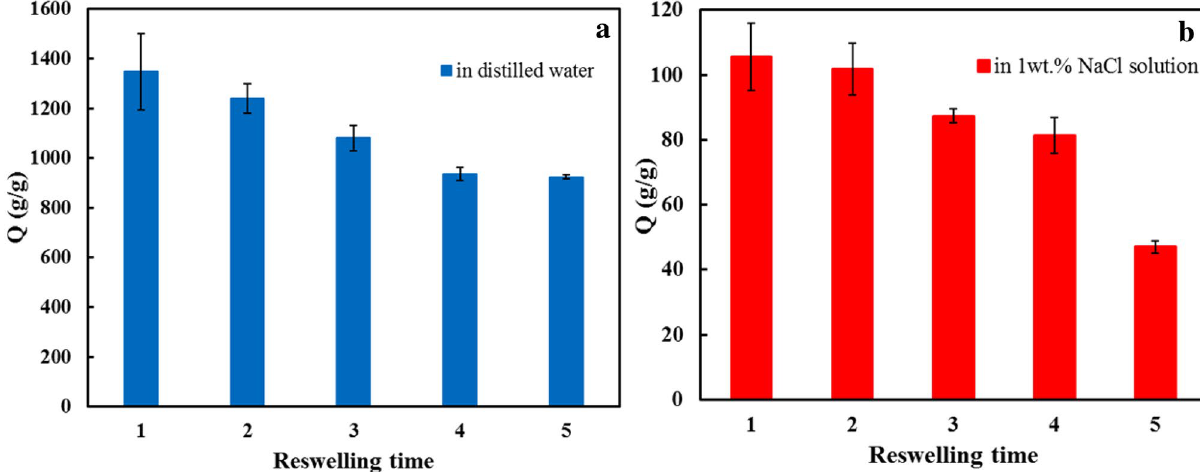
Figure 7. Reusability of p(AA-co-AM-co-MA) in ( a ) DW and ( b ) SCS.